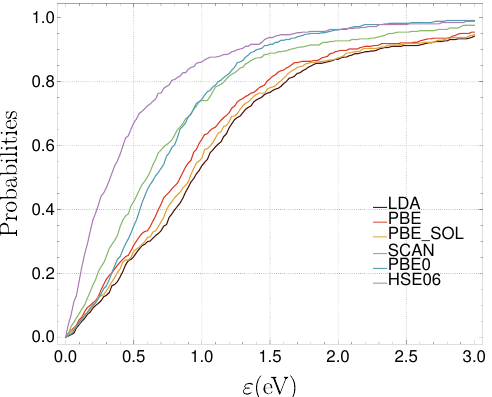
Figure 3. Empirical cumulative distribution functions for the absolute errors of the six DFAs considered in this paper. They correspond also to P r ( M , (cid:101) ) , the fraction of systems for which the DFA produces errors smaller than (cid:101) . The uncertainty bands are obtained by bootstrapping the ECDF and estimating 95% confidence intervals.